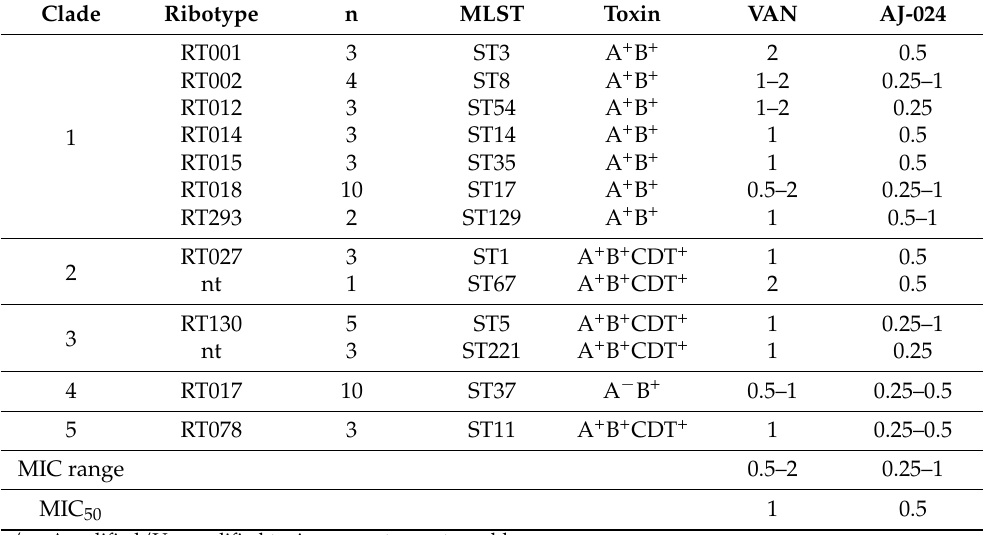
Table 2. Extensive in vitro activity of AJ-024 against highly classified 53 C. difficile. clinical isolate (minimum inhibitory concentrations (MICs), µ g/mL).